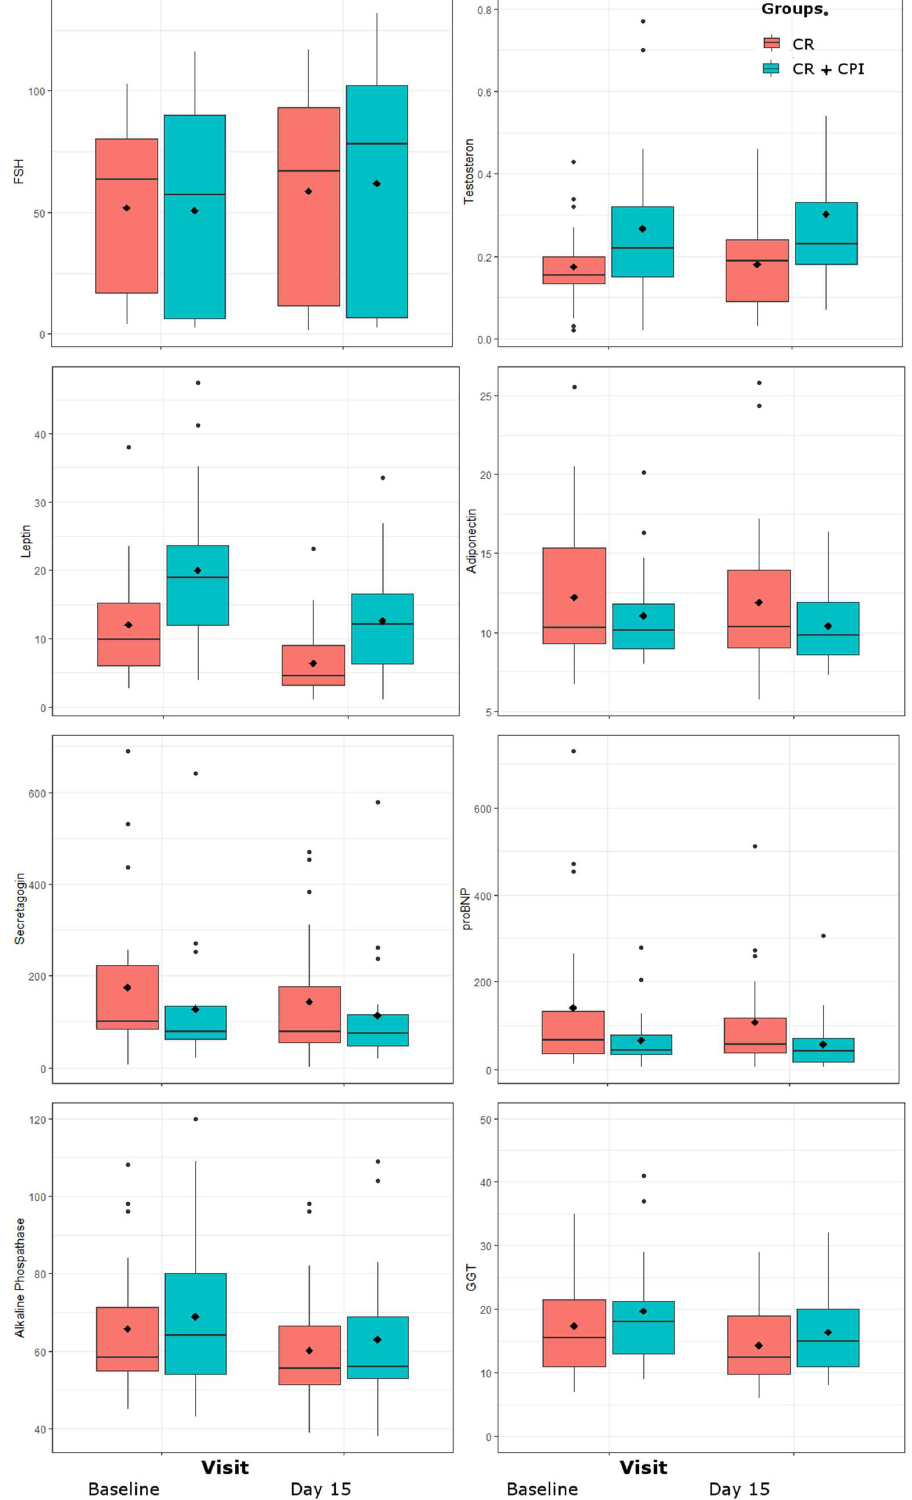
Figure 3. Changes in adipokines, sex hormones follicle-stimulating hormone (FSH) and testosterone, alkaline phosphatase, gamma-glutamyl-transferase (GGT) and pro-brain-natriuretic-peptide (proBNP) over the study period of 14 days. Values are grouped by treatment groups of caloric restriction (CR) alone and CR together with clinical psychological intervention (CPI).